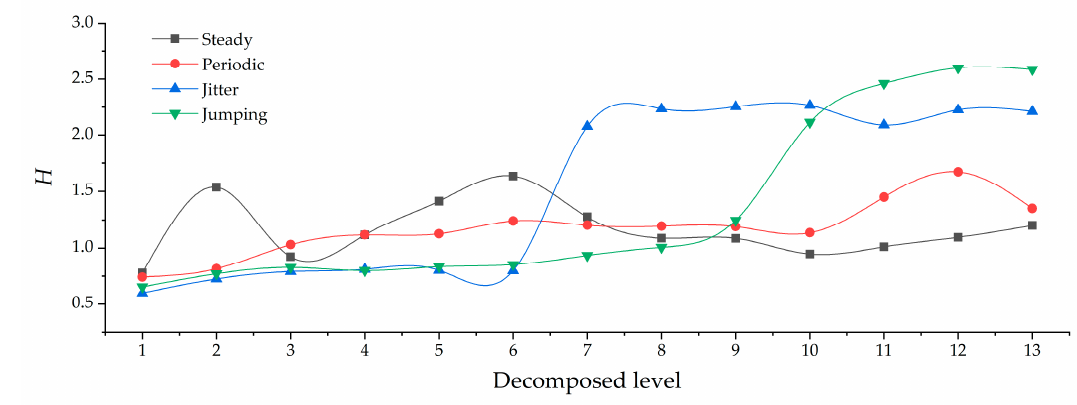
Sensors 2019 , x , x Figure 4. Time series of observed signals: ( a ) steady; ( b ) periodic; ( c ) jitter; ( d ) jumping.